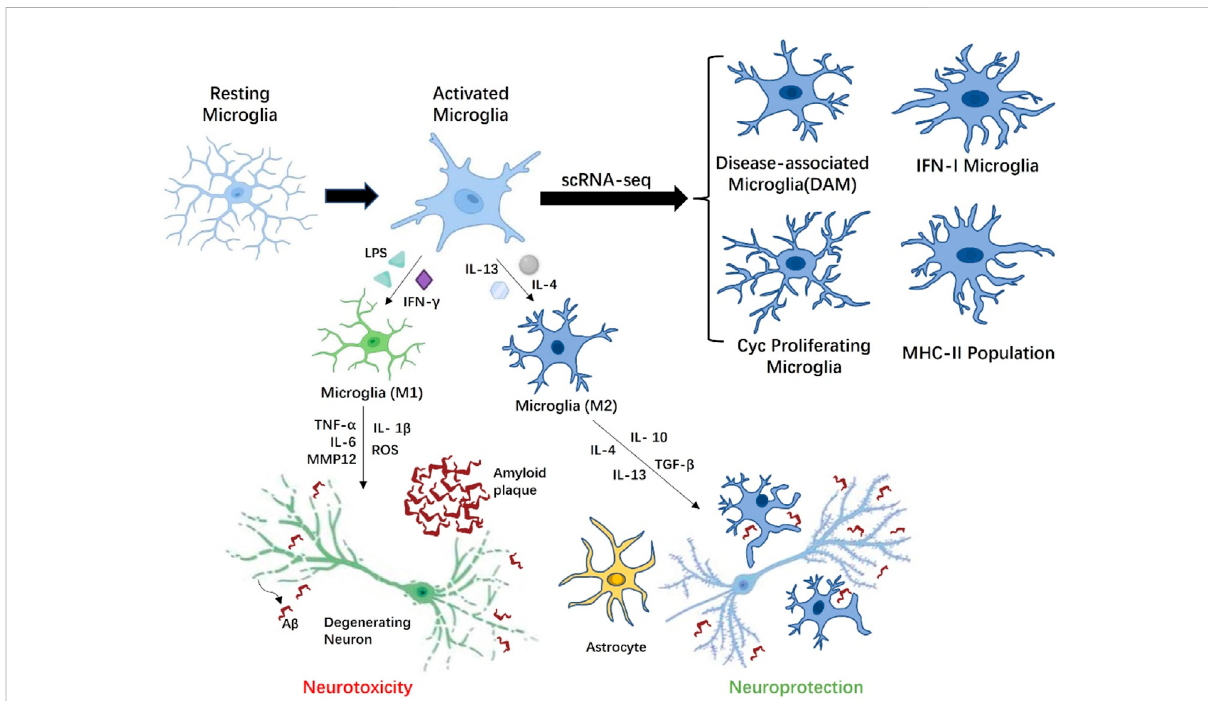
FIGURE 2 Microglia with different phenotypes participate in AD related pathological activities. Depending on the stimulation of AD microenvironment, resting microglia can be transformed into M1 phenotype microglia with neurotoxicity or M2 phenotype. microglia with neuroprotection. Under the in fl uence of amyloid beta (A β ) plaques, activated M1 microglia overproduce proin fl ammatory cytokines (IL-1 β , IL-6, and TNF- α ), which have toxic effects on neurons. M2 microglia are involved in modulating the release of anti-in fl ammatory mediators (TGF- β , IL-4, and IL-10), thereby reducing in fl ammation. Moreover, M2 microglia also cleared A β peptides by phagocytosis, limiting the damage of A β peptides to the adjacent neuropil to the greatest extent. Microglia could indirectly affect neuronal activity through astrocytes. Finally, scRNA-seq results indicated multiple activation states in microglia are context-dependent in response to A β accumulation, including disease-associated microglia (DAM) localized in the vicinity of the A β plaques, Cyc proliferating microglia, IFN-I microglia, and MHC-II